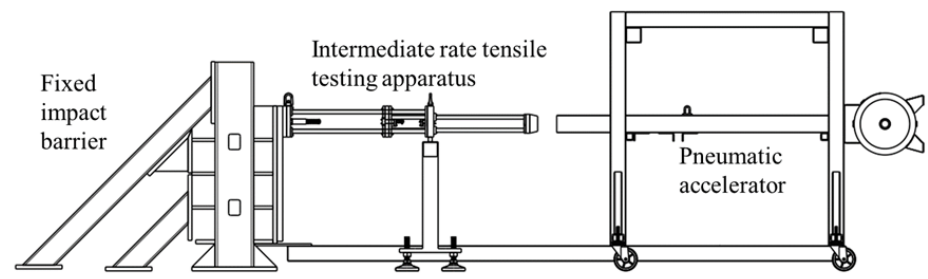
Figure 3. Intermediate strain rate tensile test apparatus integrated with fixed impact barrier and pneumatic accelerator.